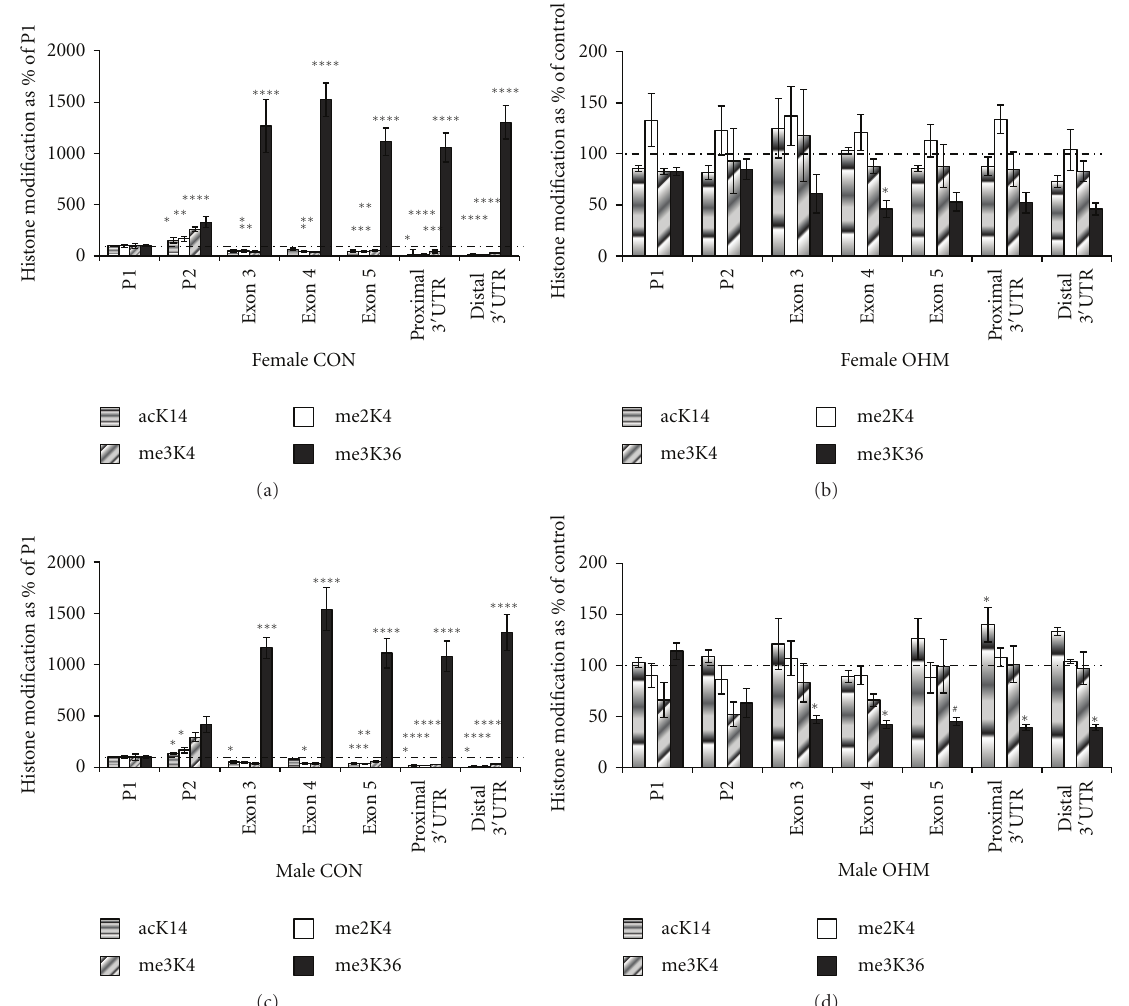
Figure 4: Maternal hyperglycemia decreased H3Me3K36 along the length of the IGF-1 gene in males. (a) Female IGF-1 histone modifications in control animals expressed as a mean percent of P1 ± standard error of the mean. (b) Female IGF-1 histone modifications in OHM animals expressed as a mean percent of gender matched control values ± standard error of the mean. (c) Male IGF-1 histone modifications in control animals expressed as a mean percent of P1 ± standard error of the mean. (d) Male IGF-1 histone modifications in OHM animals expressed as a mean percent of gender matched control values ± standard error of the mean, n = 4 CON female, n = 3 OHM female, n = 5 CON male, and n = 3 OHM male. ∗ P < 0 . 05; ∗∗ P < 0 . 01; ∗∗∗ P < 0 . 001; ∗∗∗∗ P < 0 .